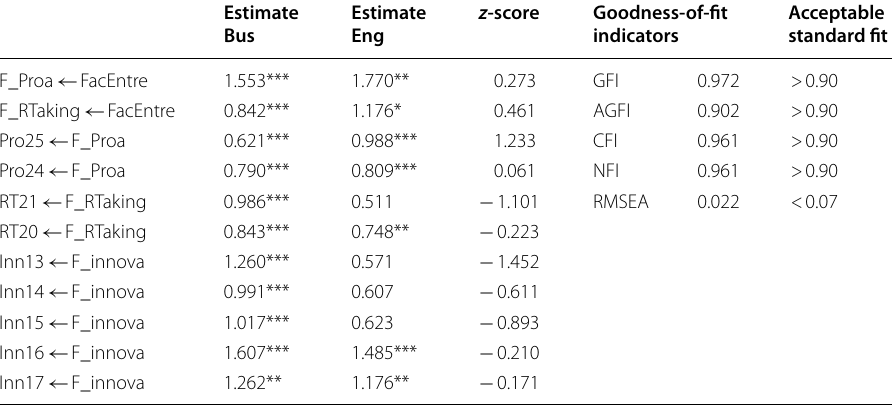
Table 6 SEM results for FEO construct subject to school